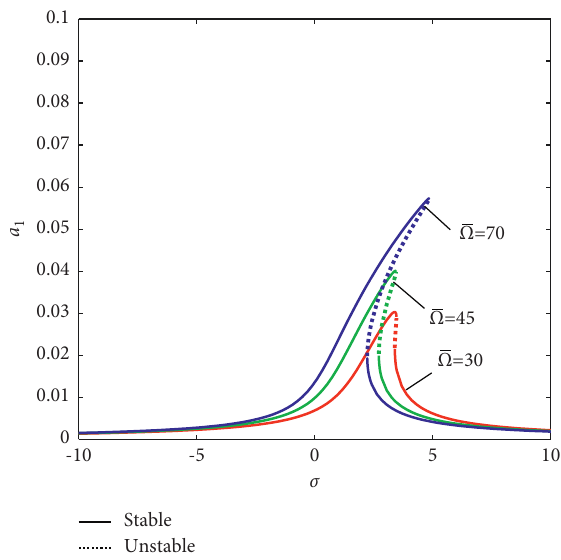
Figure 9: The effect of rotating speed on frequency response curve (L/d � 10, c � 0.01, θ � 0 ° , case I).